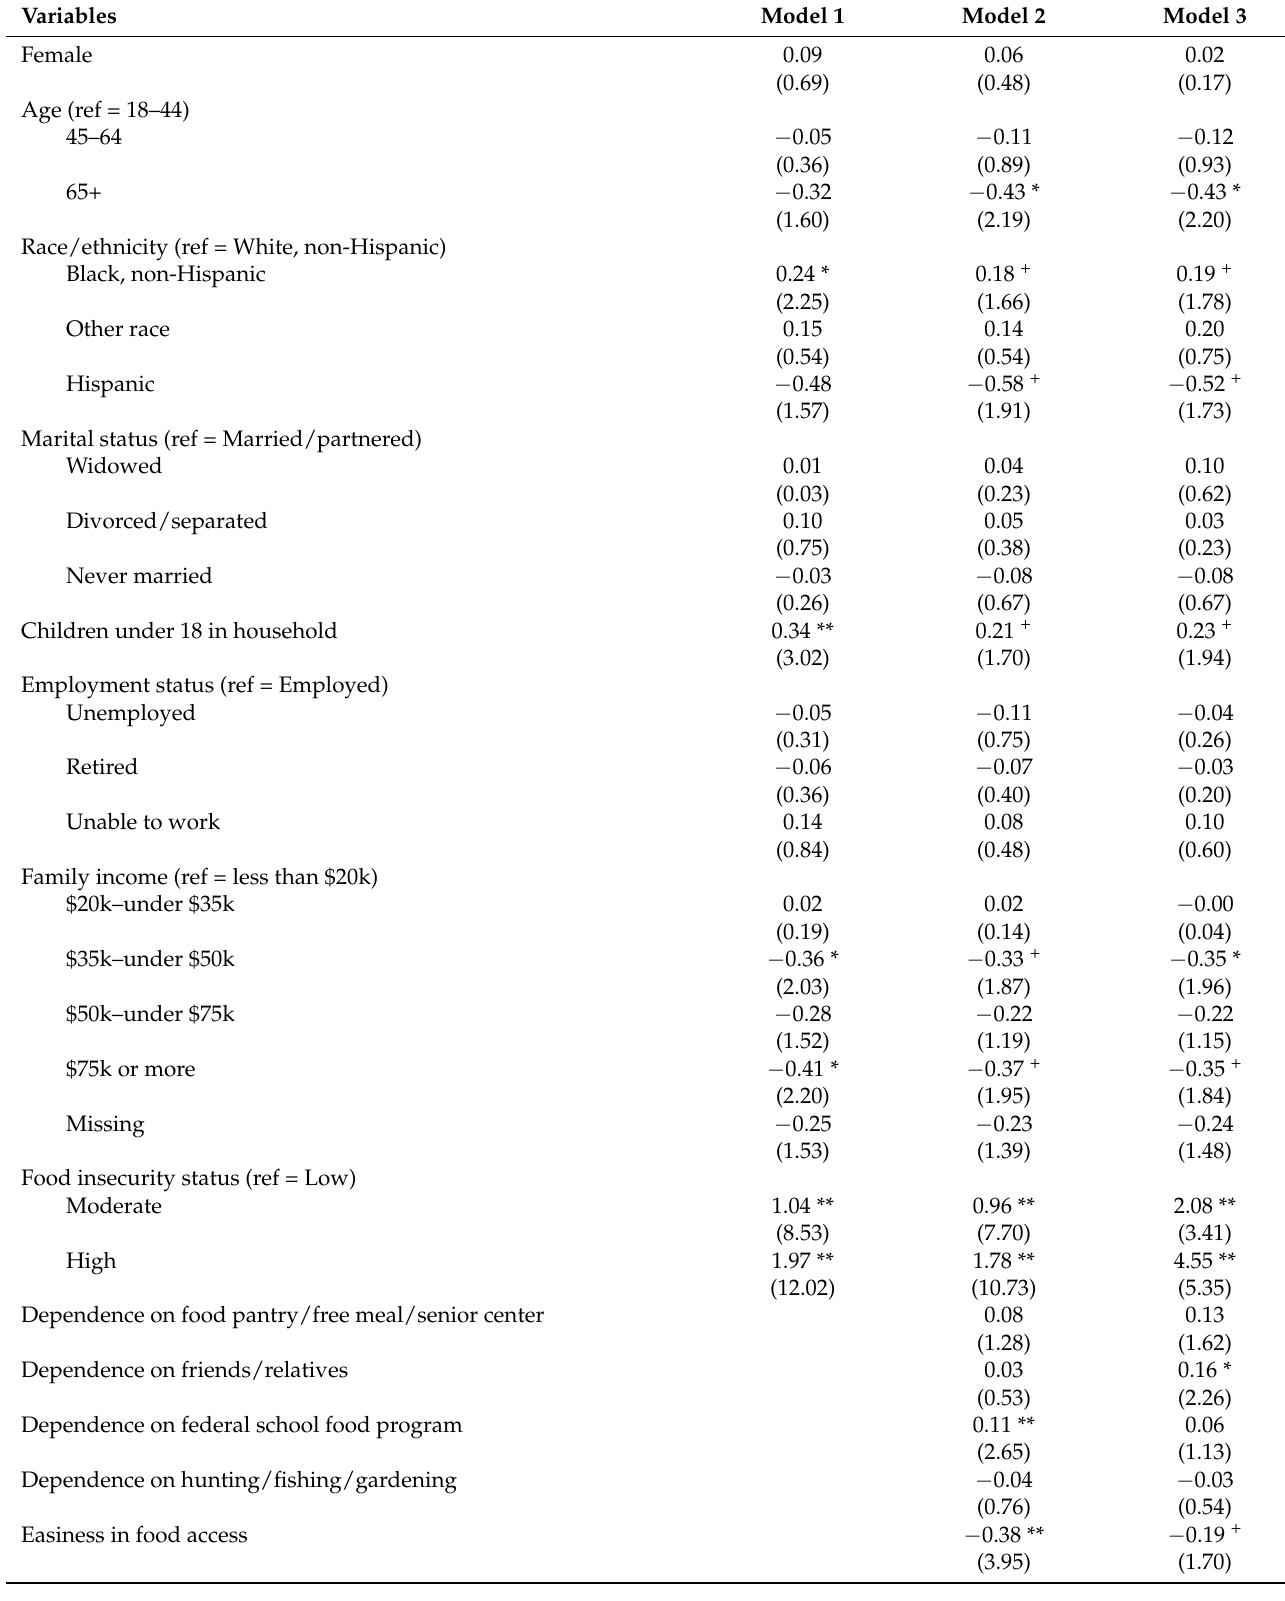
Table 3. Unstandardized coefficients from OLS regressions on making